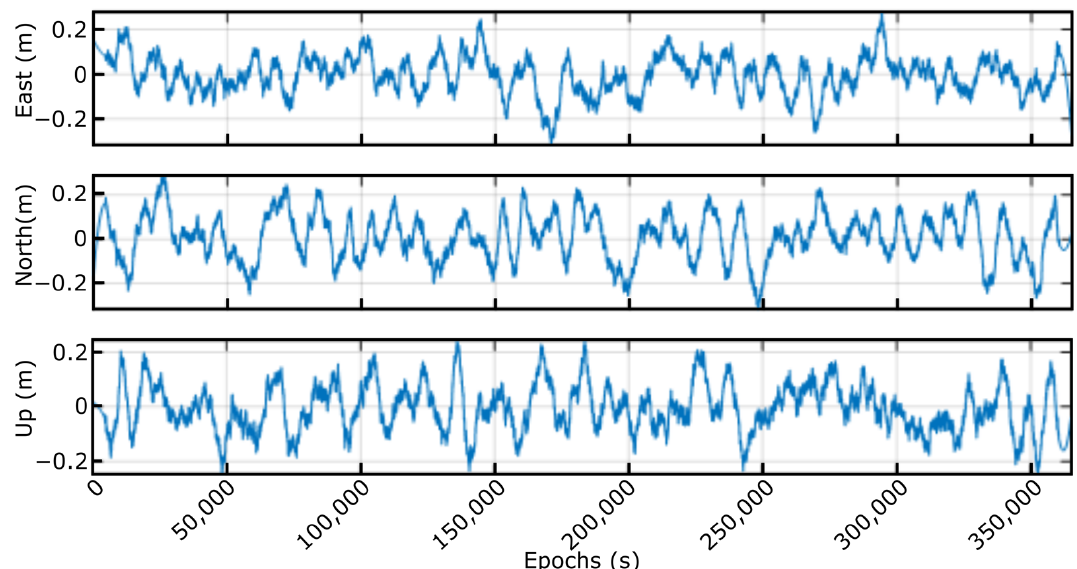
Figure 18. Error in east, north, and up components.